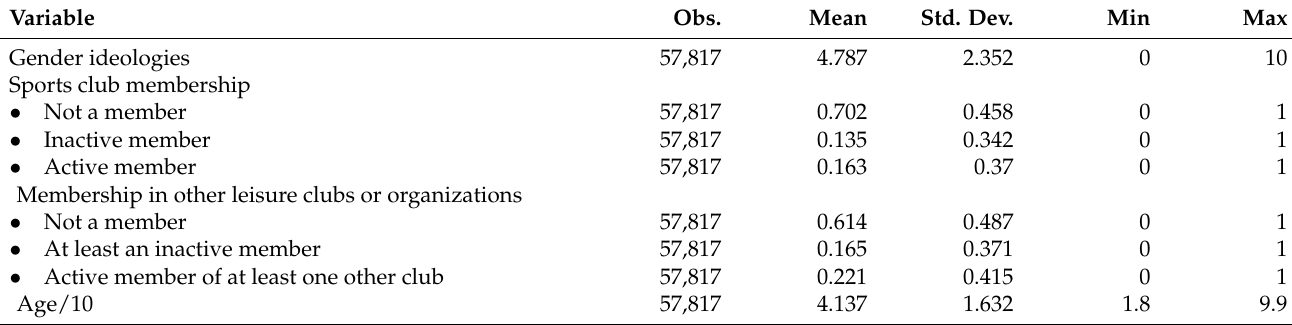
Table 1. Summary statistics for